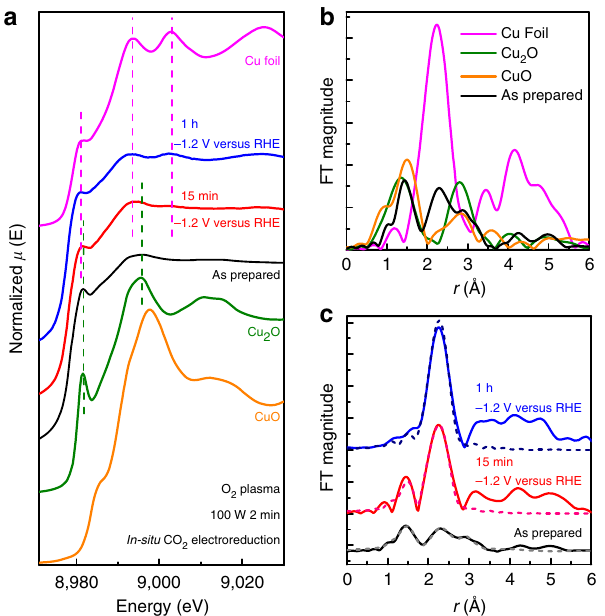
Figure 3 | Operando structural and chemical characterization during CO 2 electroreduction. ( a ) XANES spectra of the O 2 100W 2min treated sample measured under operando conditions in 0.1M KHCO 3 during the first 15min and after 1h of reaction at (cid:2) 1.2V versus RHE. Bulk Cu, Cu 2 O and CuO spectra are plotted as reference. ( b ) EXAFS spectrum of the as- prepared sample plotted with references. ( c ) EXAFS spectra and fits (dashed lines) of the sample measured under operando conditions. Fourier transforms are k 2 -weighted. Fit results are given in Supplementary Table 2.